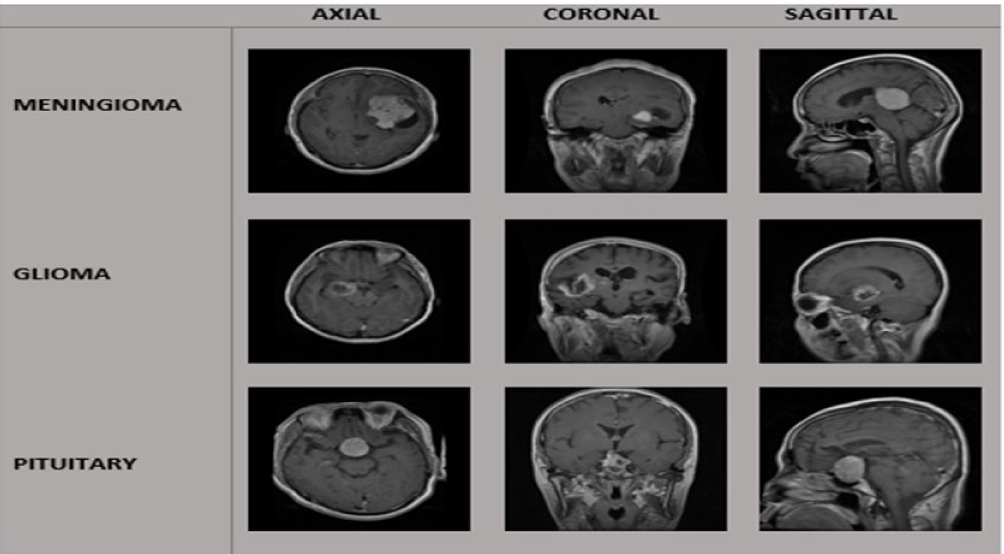
Figure 1. Three different tumors (meningioma, glioma, and pituitary tumor) in three different